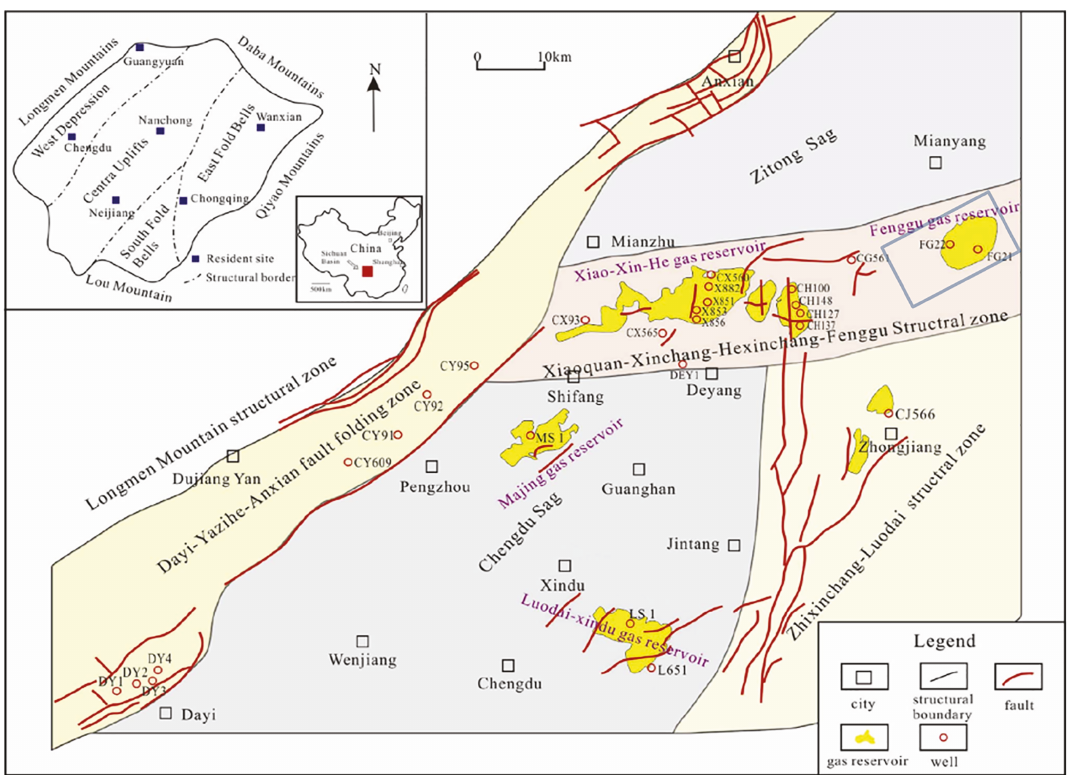
Figure 5: Location of Fenggu area and tectonic divisions of western Sichuan Basin [29]. The Fenggu structure is located in eastern end of the Xiaoquan-Hexingchang-Xinchang-Fenggu structural zone in western Sichuan depression, China. The area framed by blue rectangular is the objection area of the